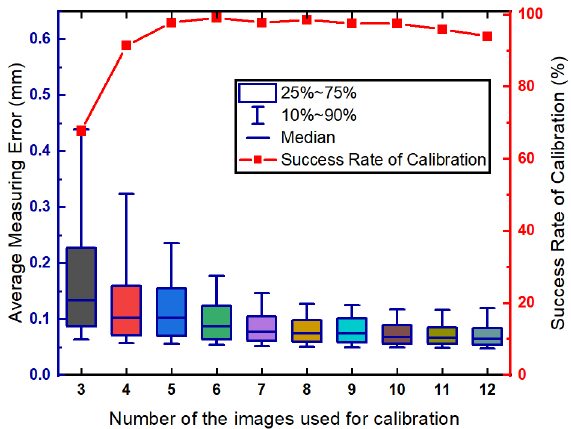
Figure 5. The influence of the number of the images.